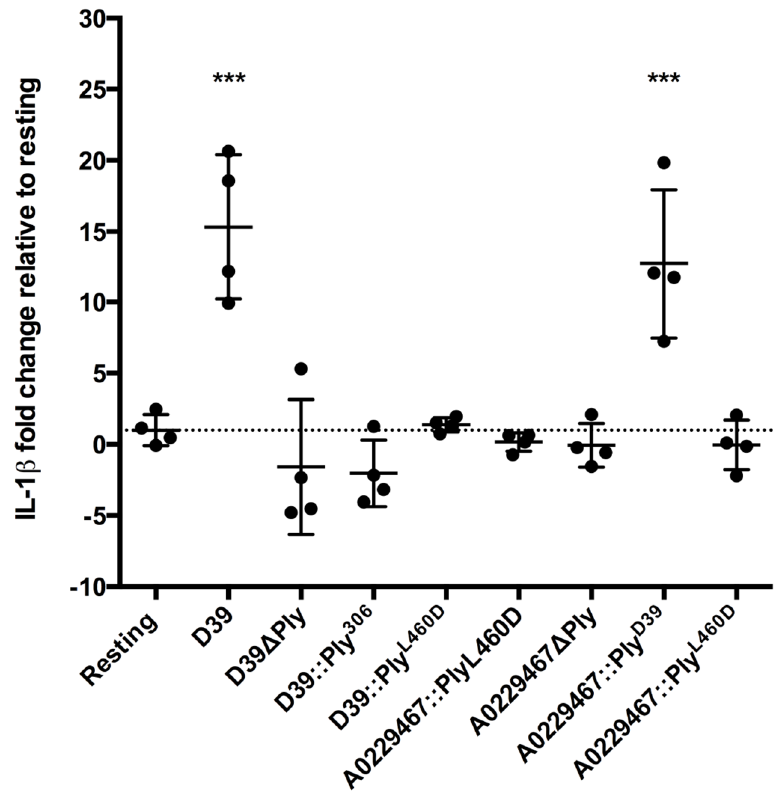
Figure 3. Ply-dependent induction of IL-1 b release requires cytolytic activity. Differentiated THP-1 cells were co-incubated with bacteria at a 1:10 ratio for 16 h. Supernatants were collected and IL-1 b levels measured by ELISA. The mean quantity of IL-1 b detected from resting samples is set at a relative value of 1 (dashed line), with all data points plotted as fold-change from this value. Error bars indicate the mean with standard deviation. Significant increases in IL-1 b levels are highlighted, ***= P , 0.001, n=4.